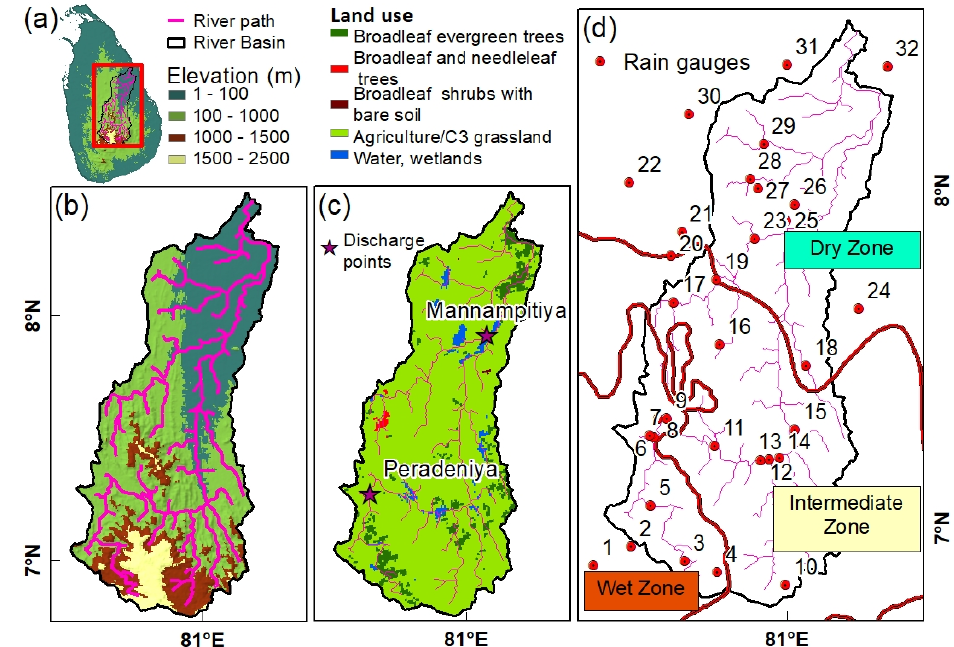
Figure 2. ( a ) Topographical map of Sri Lanka with the demarcation of the Mahaweli River basin, ( b ) topography of the Mahaweli River basin, ( c ) land use with distribution of discharge measurement points, and ( d ) demarcation of climatic zones with rain gauge network.